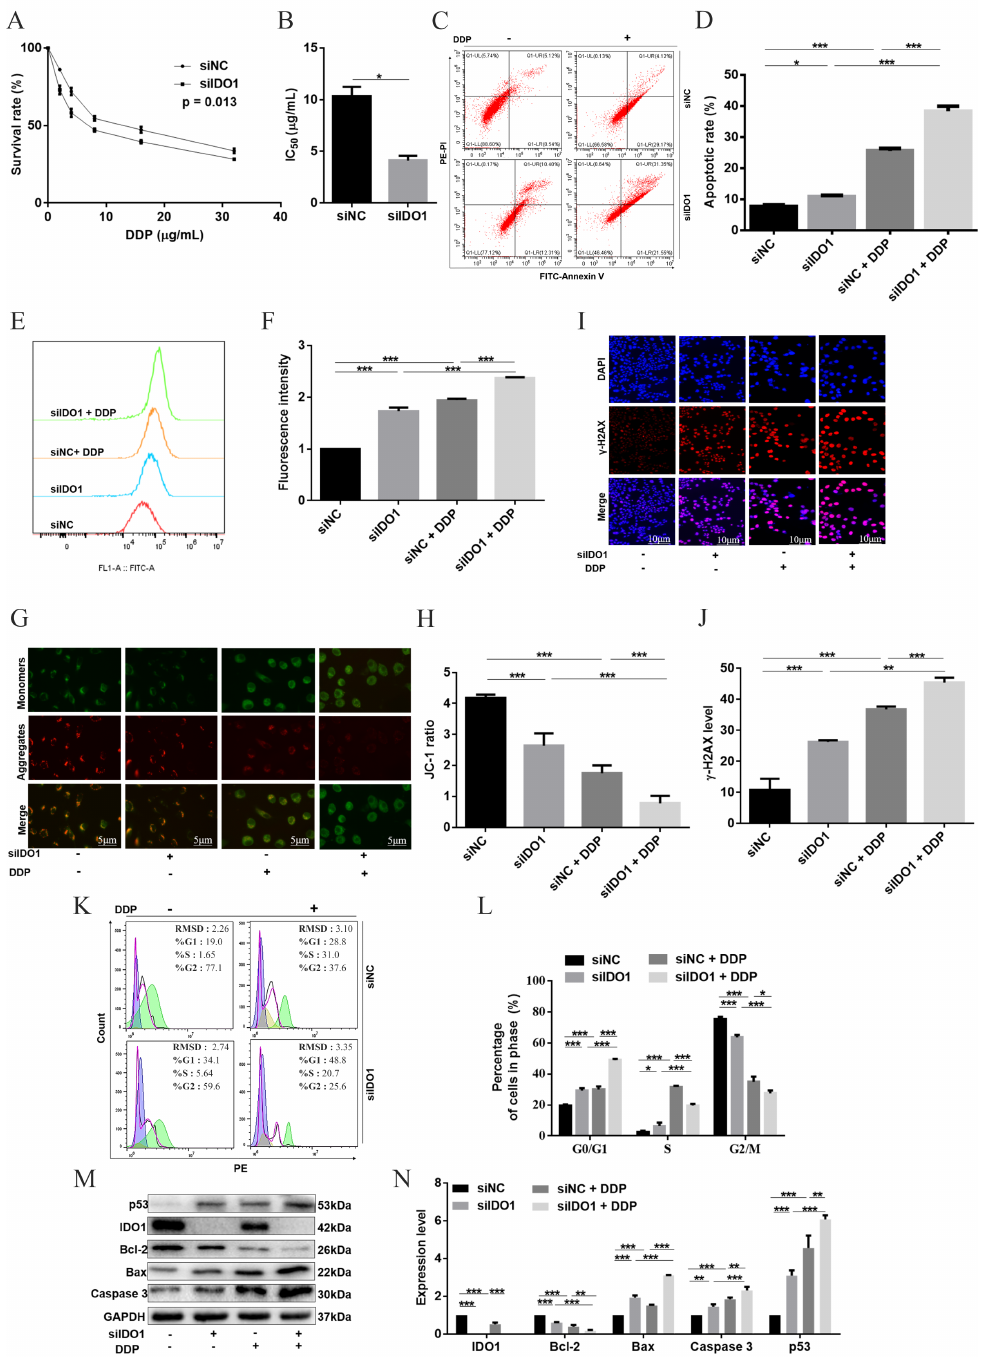
Figure 3. Silencing IDO1 enhanced DDP-induced apoptosis in SKOV3 cells. ( A , B ) Cell-survival percentages and IC 50 of DDP. ( C , D ) Apoptosis was determined by the Annexin V assay. ( E , F ) ROS generation was detected by flow cytometry. Data were expressed as mean fluorescence intensity. ( G , H ) MMP determined with the JC-1 assay; representative images of J-aggregates (red) and monomer (green); the scale bar was 5 µ m; JC-1 ratio reflected MMP. ( I , J ) DNA damage marker γ -H2AX assayed with immunofluorescence (red), cells were counterstained with DAPI to visualize nuclei (blue); representative images; the scale bar was 10 µ m; the fluorescent intensity indicated the γ -H2AX level. ( K , L ) Cell cycle examined by flow cytometry. ( M , N ) Apoptosis-related proteins analyzed by western blot. Data were mean ± standard deviation for 3 independent trials. *: p < 0.05; **: p < 0.01; ***: p < 0.001.